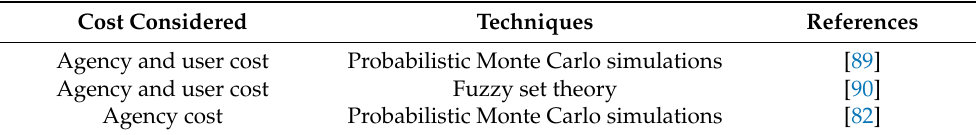
Table 4. Life cycle cost analysis techniques and cost